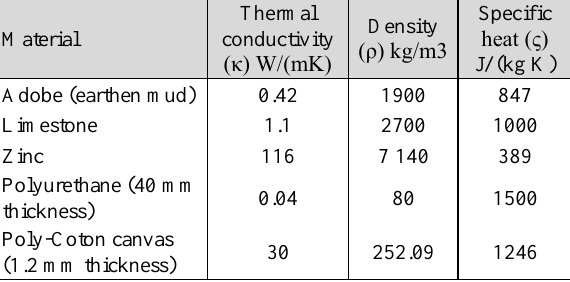
Table 3. Thermal properties of materials used in the models.